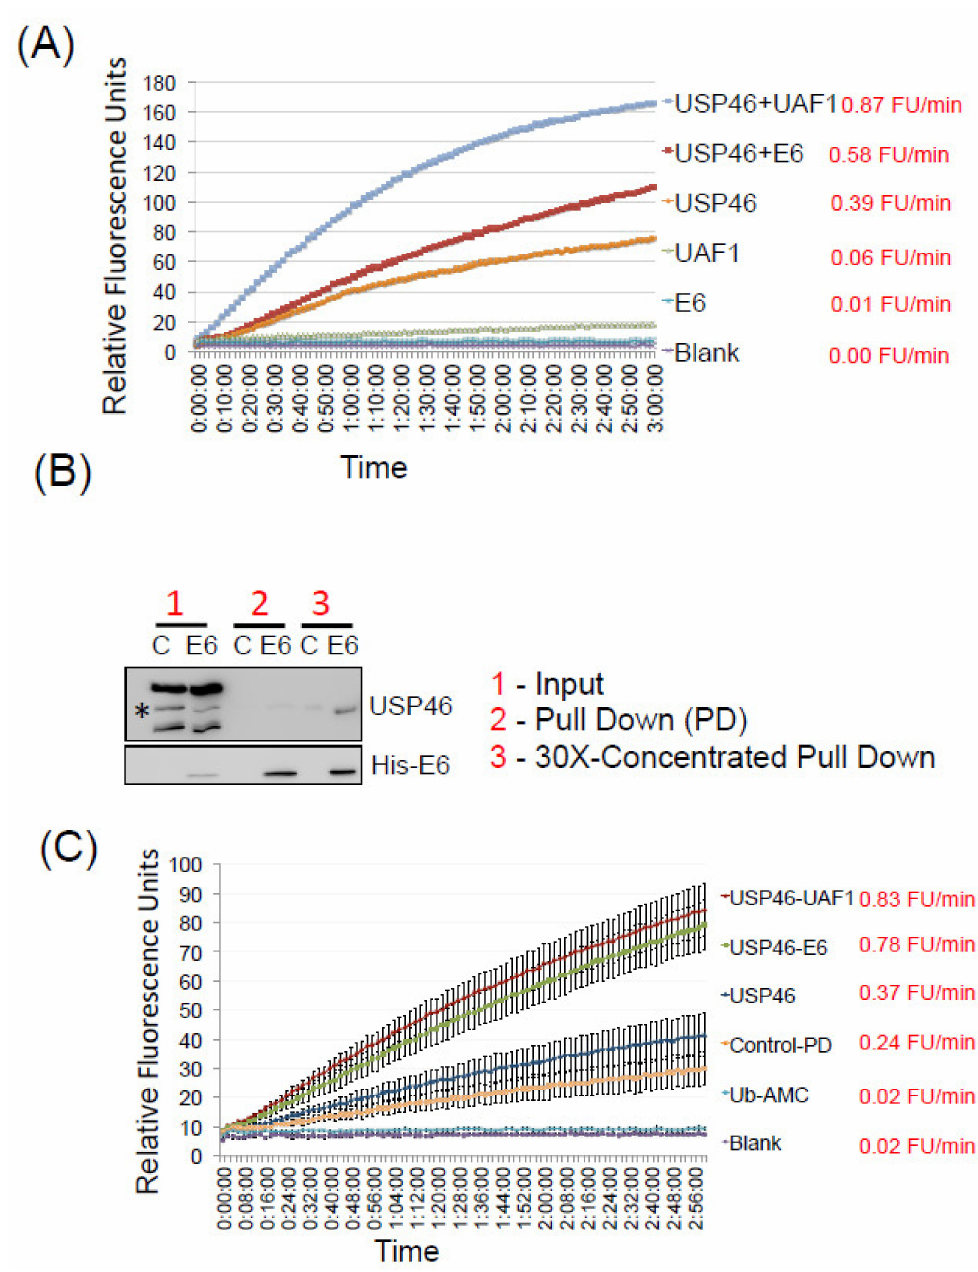
Figure 4. ( A ) Ub-AMC deubiquitination assay: Fluorescence intensity of 7-amido-4-methylcoumarin (AMC) fluorophore released from Ub-AMC substrate indicating the deubiquitinase activity of indi- cated proteins. Marker indicates 1-min time point measurements for 3 h after start of the reaction. Ub-AMC alone was used as the blank input. ( B ) Untagged USP46 expressing Sf9 cell lysates was mixed with His-E6 protein overnight followed by purification of the complex on Ni-NTA columns. Purified complex was concentrated 30 times. Input, purified and concentrated (30 × ) complex were immunoblotted with indicated antibodies. ( C ) Deubiquitination assay as in ( A ), with the purified